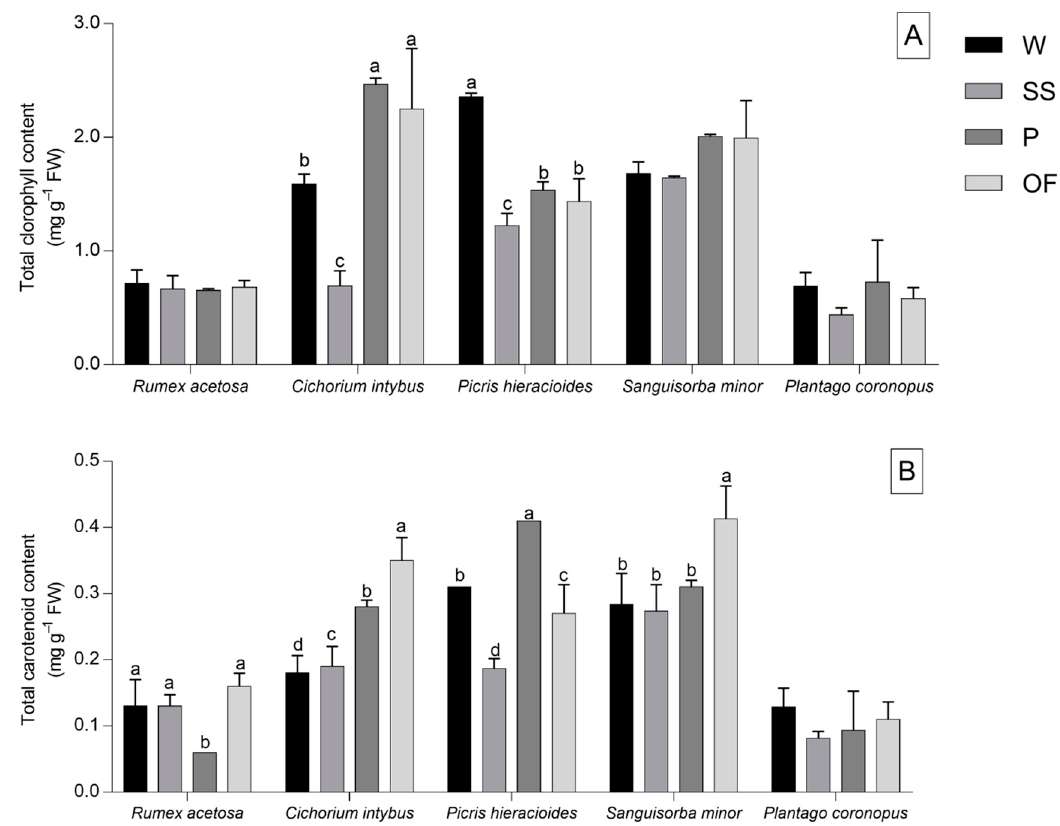
Figure 2. Total phenolic ( A ) and total flavonoid ( B ) contents of Rumex acetosa , Cichorium intybus , Picris hieracioides , Sanguisorba minor , and Plantago coronopus wild-collected (W) and domesticated according to three different methods: “soilless” (SS), pot (P), and open field (OF). Each value is the mean (± SD) of three replicates. Means keyed with a different letter are significantly different for p = 0.05 considering each species independently and following one-way ANOVA, with wild-collection or the different domestications as the variability factor.